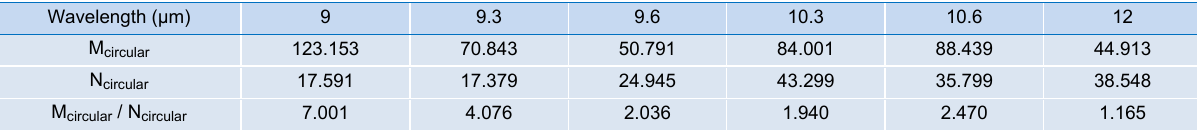
Table 2 | Comparison of the extinction ratio between the polarization-dependent optimization method proposed in this paper and the conventional design method when modulating circular